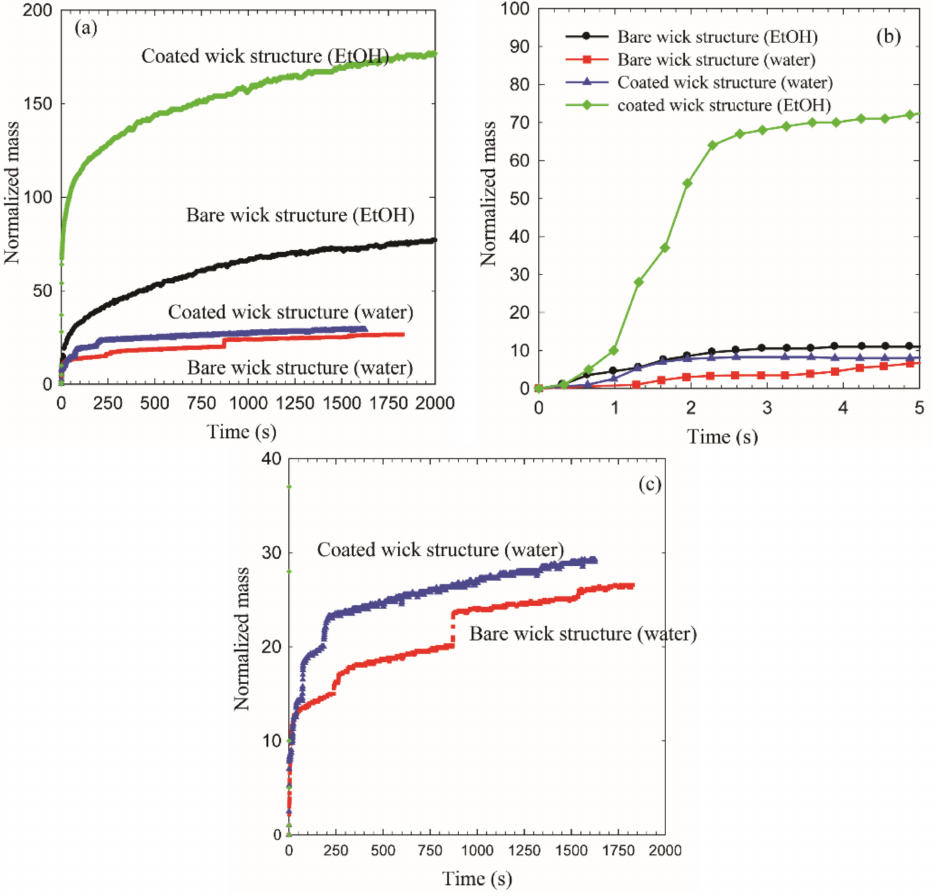
Figure 5. Capillary rise by mass gain approach; ( a ) comparison of all tested wick structure; ( b ) capillary rate at initial wicking; ( c ) closer look of step-rise wicking rise with water as a working